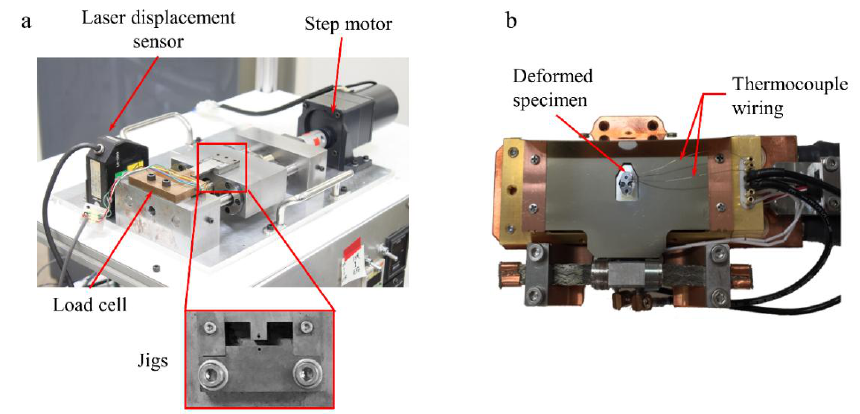
Figure 2. ( a ) Device employed for tensile test; ( b ) deformed specimen set on in situ heating stage.